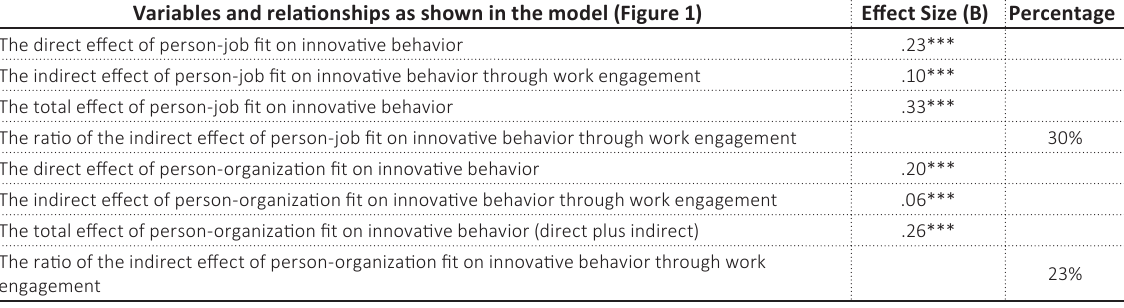
Table 3. Direct and indirect effect size Variables and relationships as shown in the model (Figure